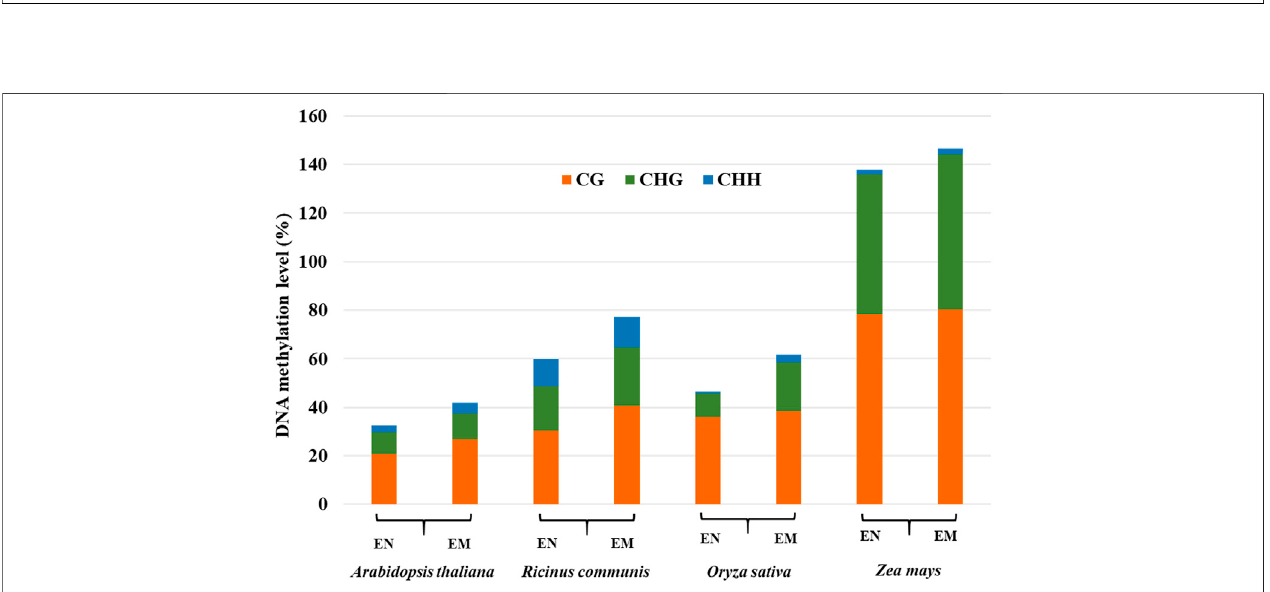
FIGURE 3 | DNA methylation levels of CG, CHG, and CHH in the endosperm (EN) and embryo (EM) among different species.